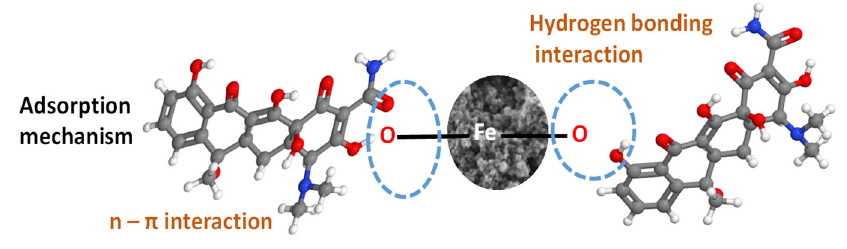
Figure 7. The likely mechanism of the adsorption of tetracycline on maghemite.